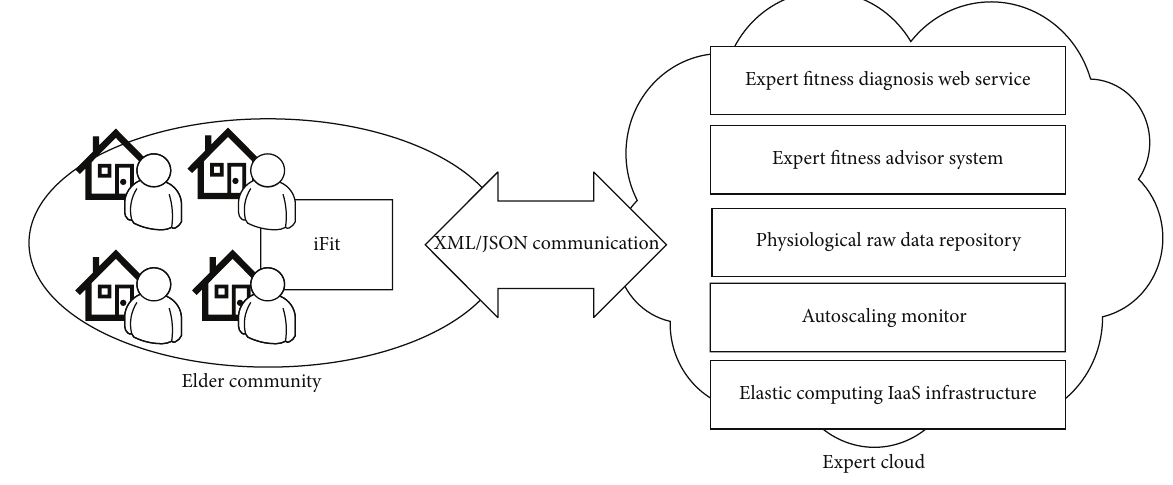
Figure 1: Overview of expert cloud architecture.